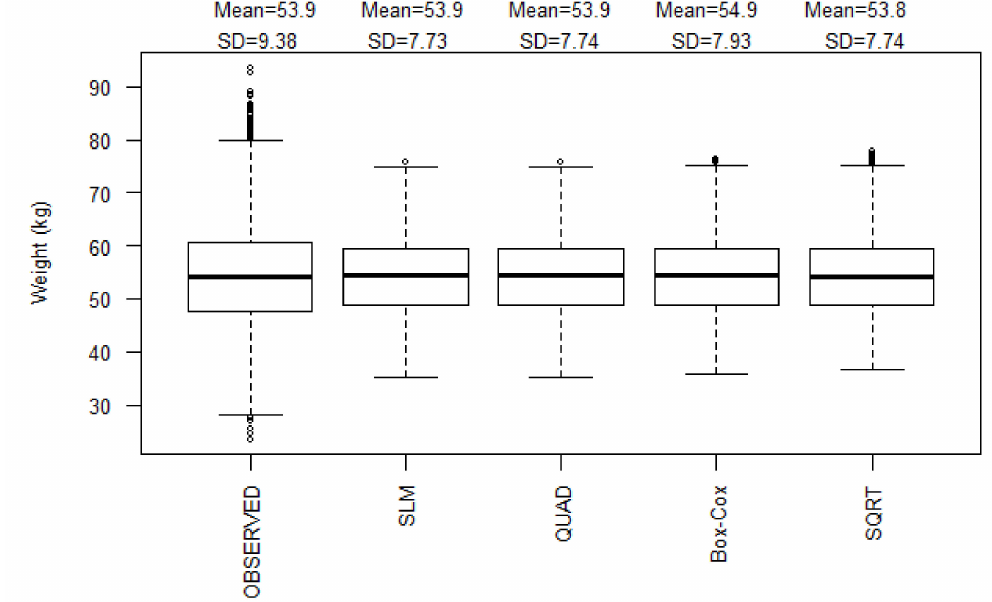
Figure A1. Boxplot summarizing liveweight predictions on the testing dataset; the bottom and top of the box show the 25th and 75th percentiles respectively, whiskers present the 1.5 times the interquartile range of the data, and the thick black solid horizontal line is the median. SD is the standard deviation in kg.